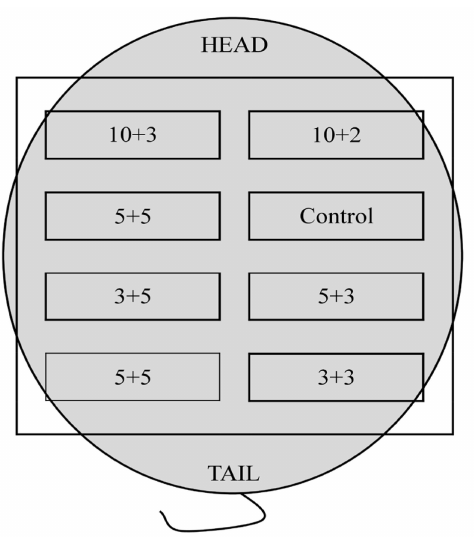
Figure 2. Example scheme of sample implantation. The squares indicate the implantation sites, the numbers indicate the concentration of CMCS + PEGDA, and the “Control” is a commercial